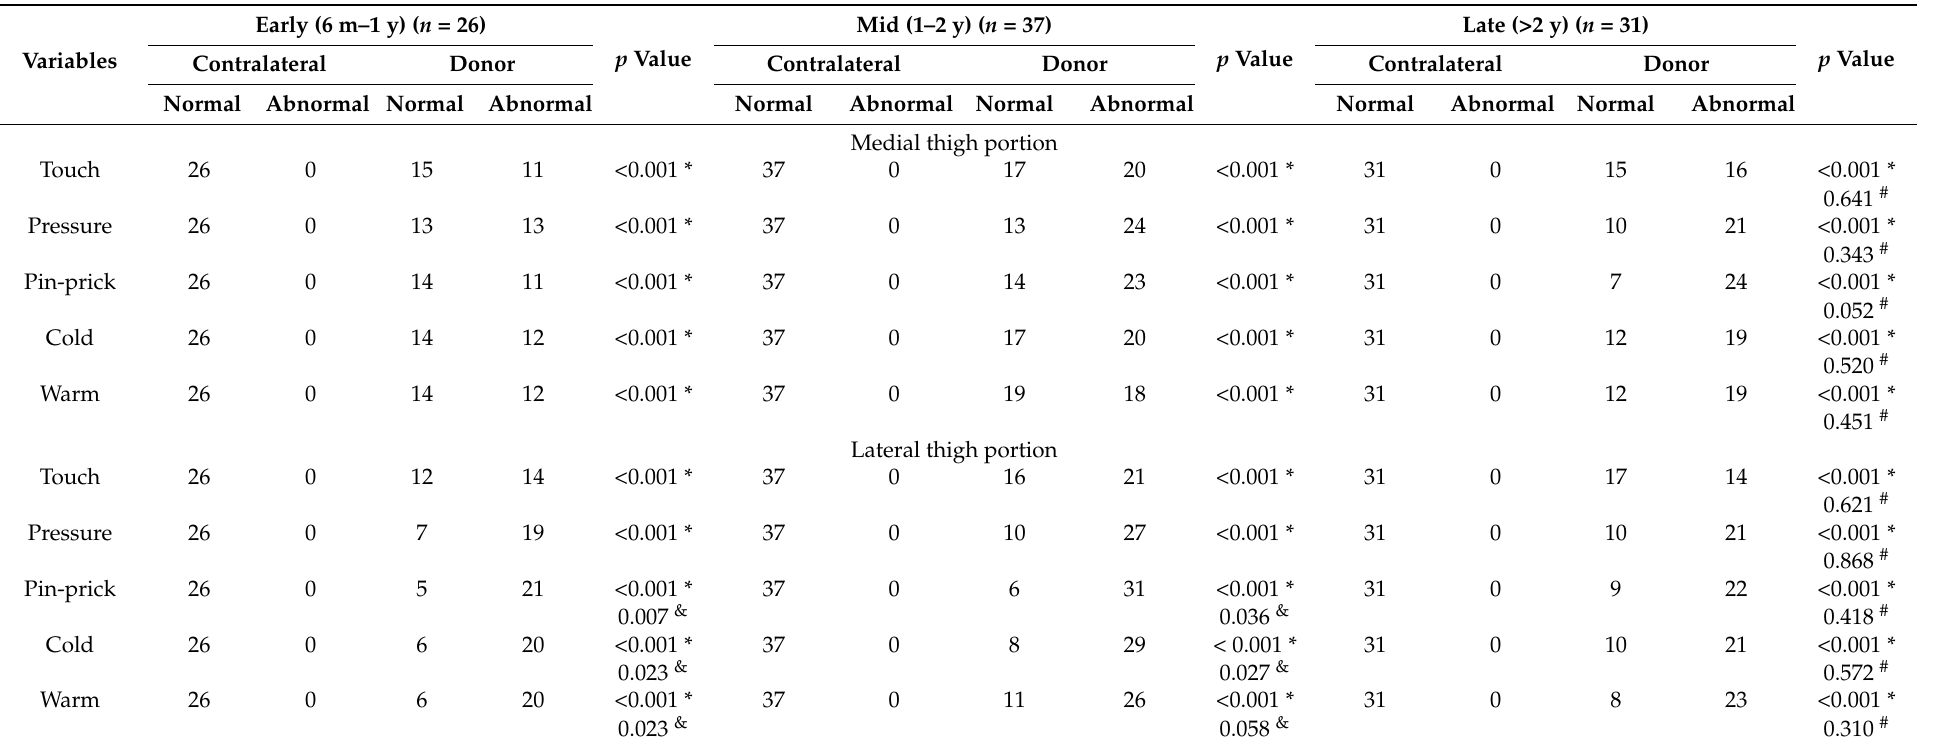
Table 3. Different stimulus responses either on the medial and lateral donor or contralateral thigh skins following anterolateral thigh flap